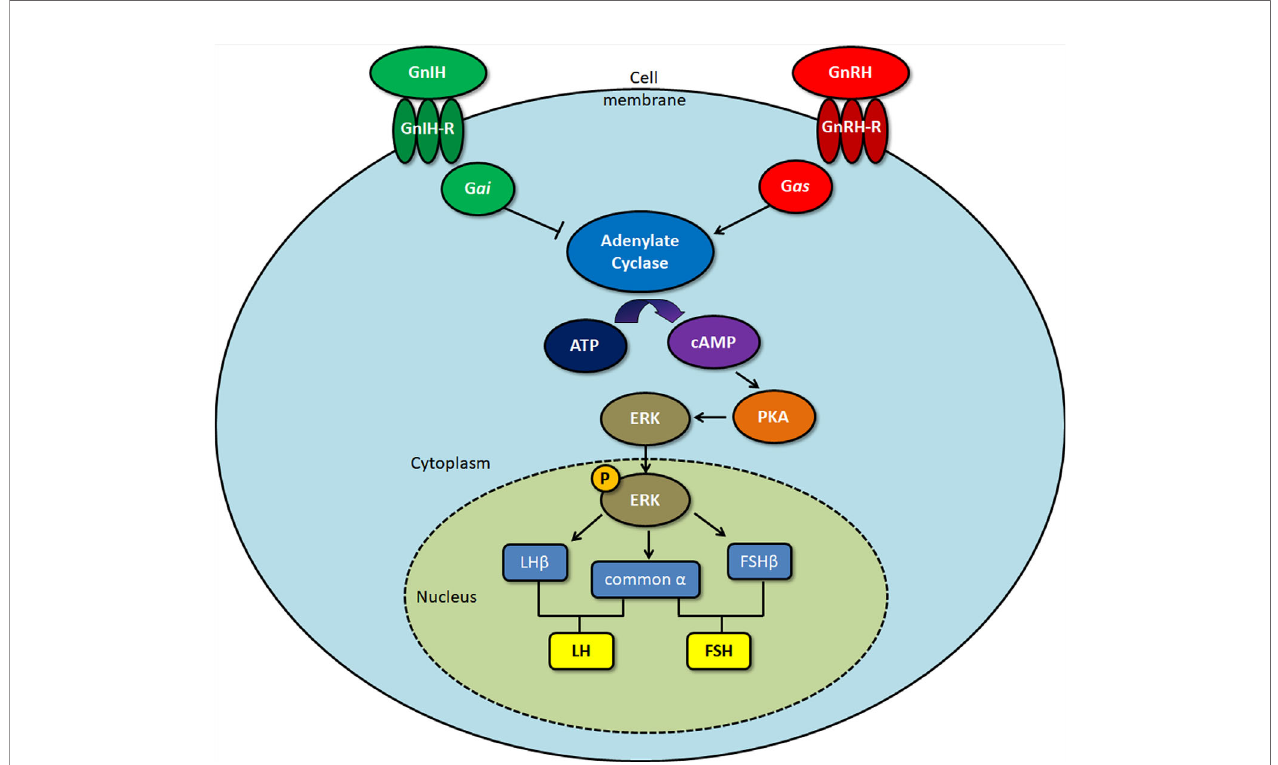
FIGURE 1 | Signaling pathway of gonadotropin-inhibitory hormone (GnIH)/RFamide-related protein (RFRP)-3 upon binding to the GPR147 GnIH receptor. Protein kinase A (PKA), extracellular signal-regulated kinase (ERK). Gonadotropin-releasing hormone (GnRH) binds to the GnRH receptor, activating G as protein, which induces cAMP production. Upon binding to the GnIH receptor, G ai protein acts to inhibit GnRH-induced cAMP production, leading to a decrease in ERK activation. As phosphorylated ERK is involved in the transcription of the gonadotropin subunits LH b , FSH b , and common a , this ultimately results in downregulation of the gonadotropins that are formed, luteinizing hormone (LH) and follicle-stimulating hormone